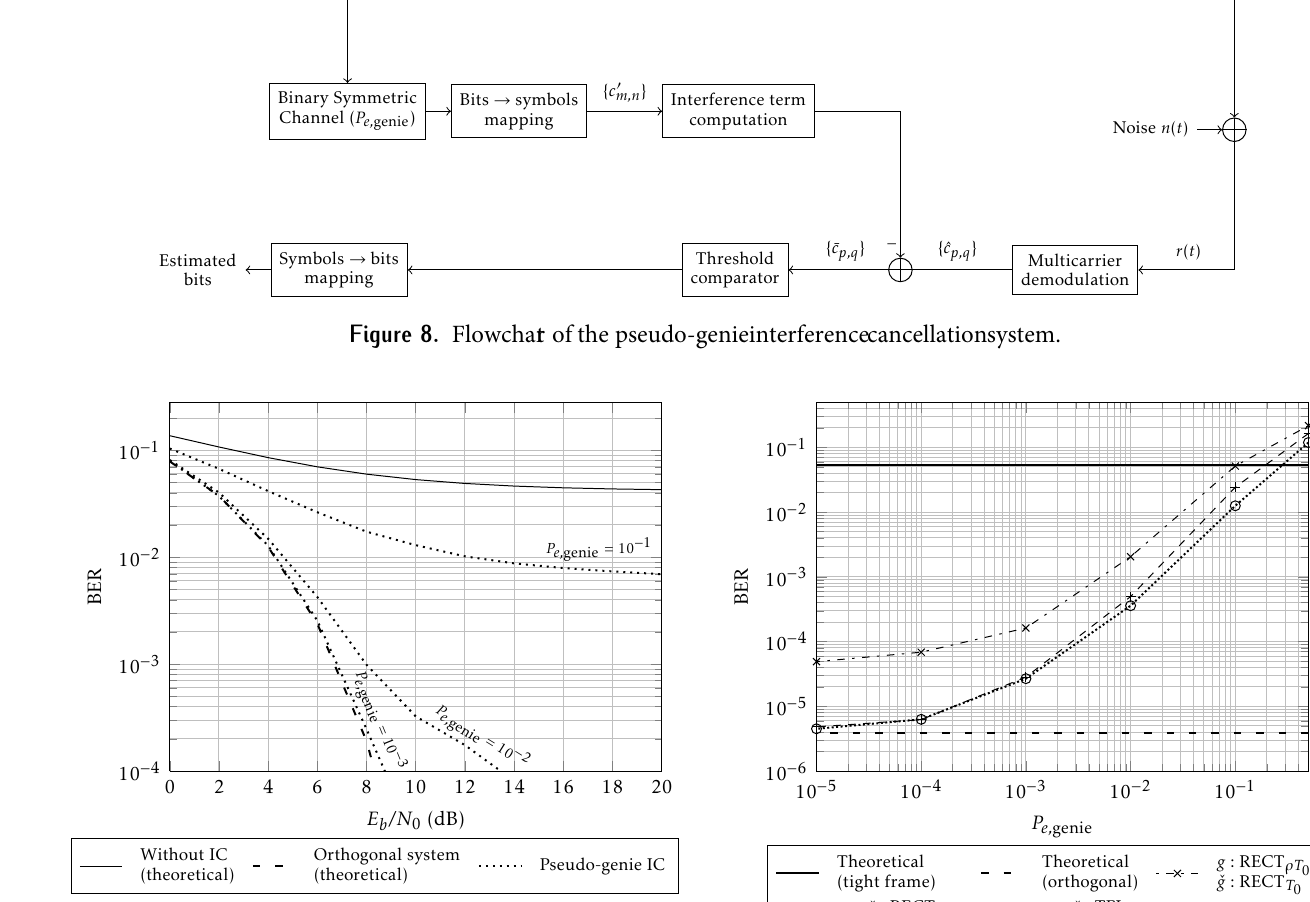
e, genie , with a pseudo-genie